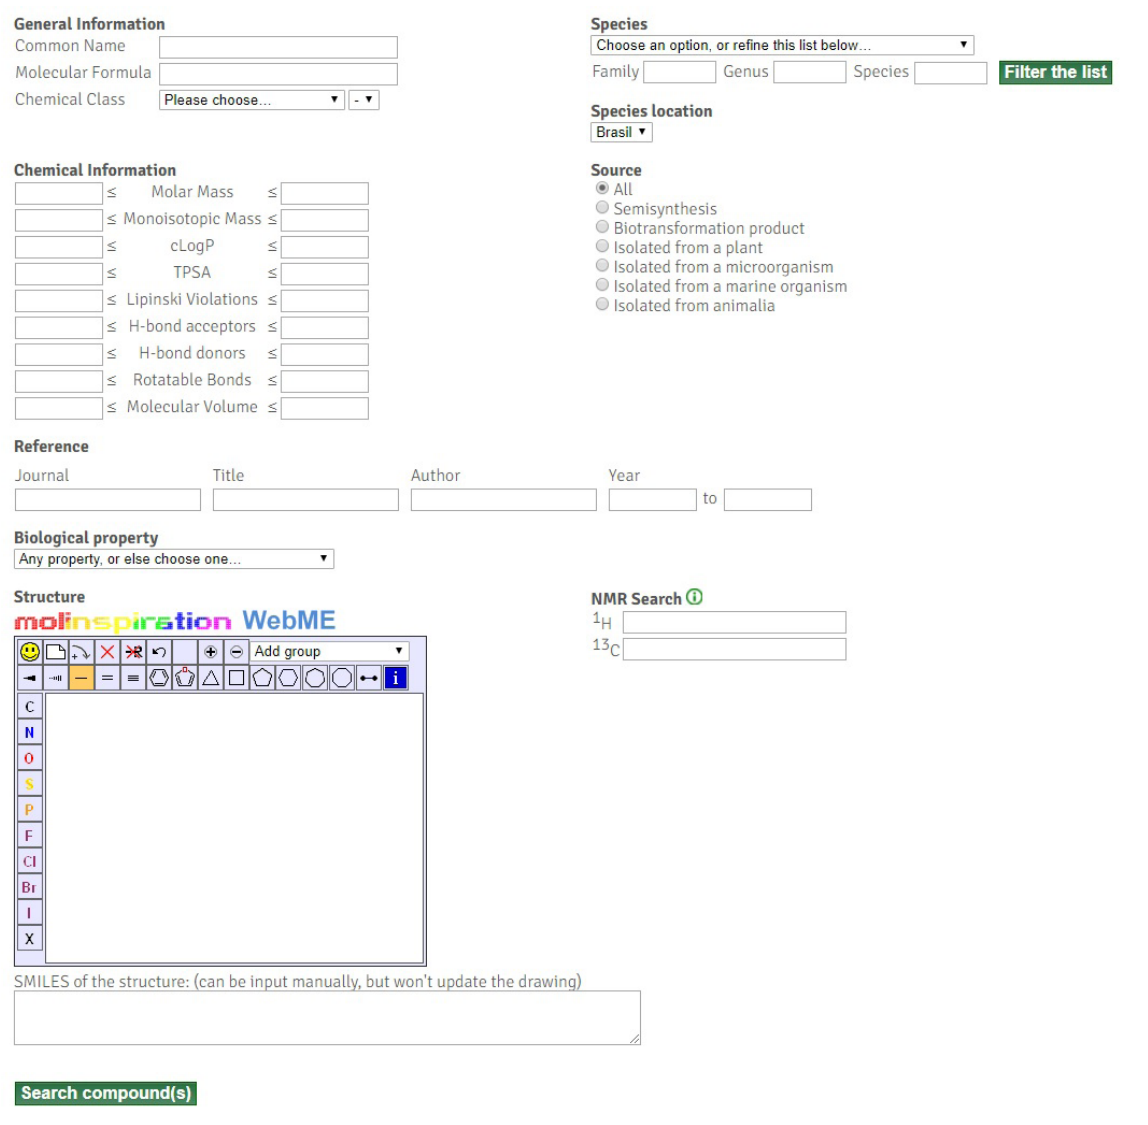
Figure 11 - Layout of the search platform on NuBBE